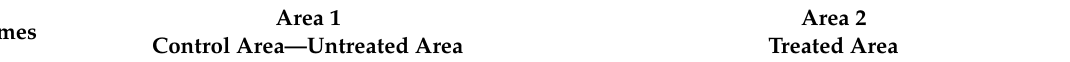
Experimental Times T − 1